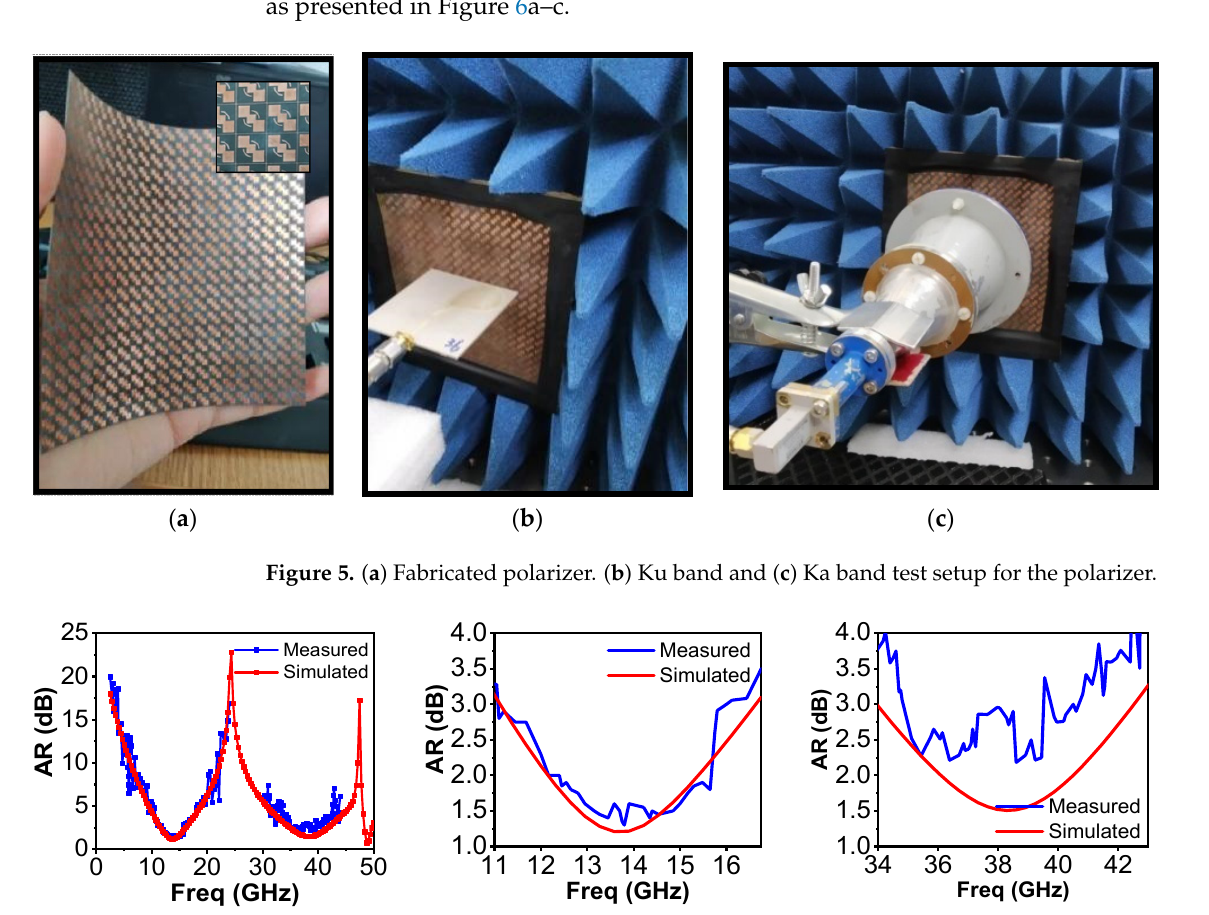
Figure 6. ( a ) Measured axial ratio response; ( b ) AR within Ku operational band; ( c ) AR within Ka operational band .